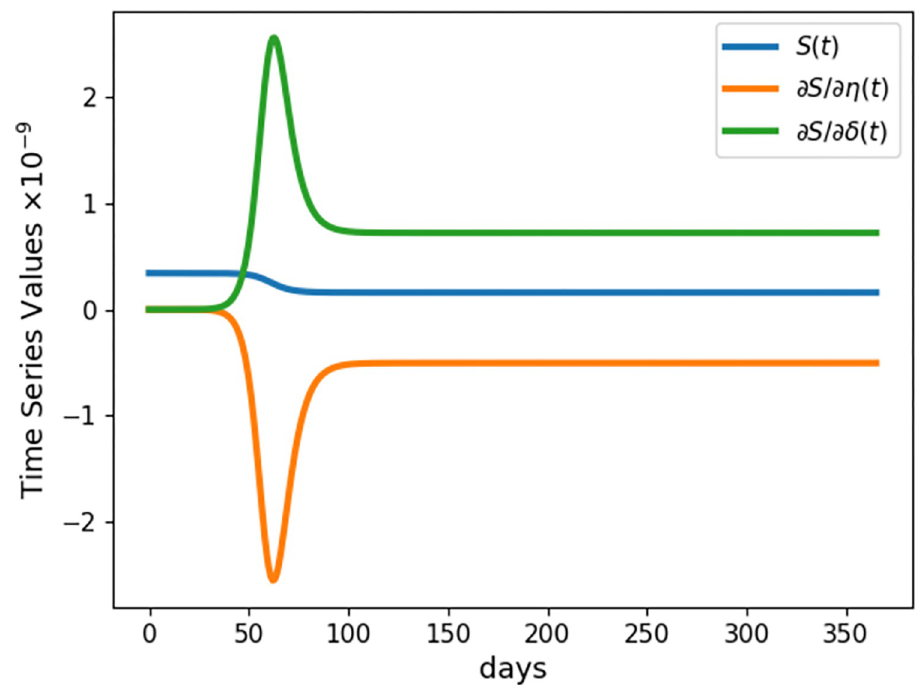
Fig 3. Sensitivities of Susceptibles in the Covid Model. Time series of the susceptible population ( S ( t )) and its sensitivities to the two parameters ( η and δ ) of the classic SIR model. Results shown are for the SIR model simulated for one year with initial conditions S 0 = 3.4 × 10 8 , I 0 = 100, R 0 = 0, and the parameter values η = 0.7194, δ = 0.5025. Derivatives are calculated using the complex perturbation method.